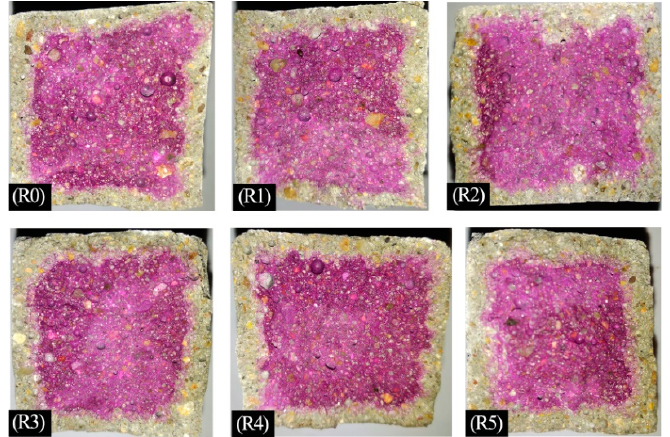
Figure 4. Image of carbonation depth under mechanical agitation (28 d) . Table 3. Absorb different amounts of CO 2 and carbonize depth at different ages (mechanical agitation). Specimen